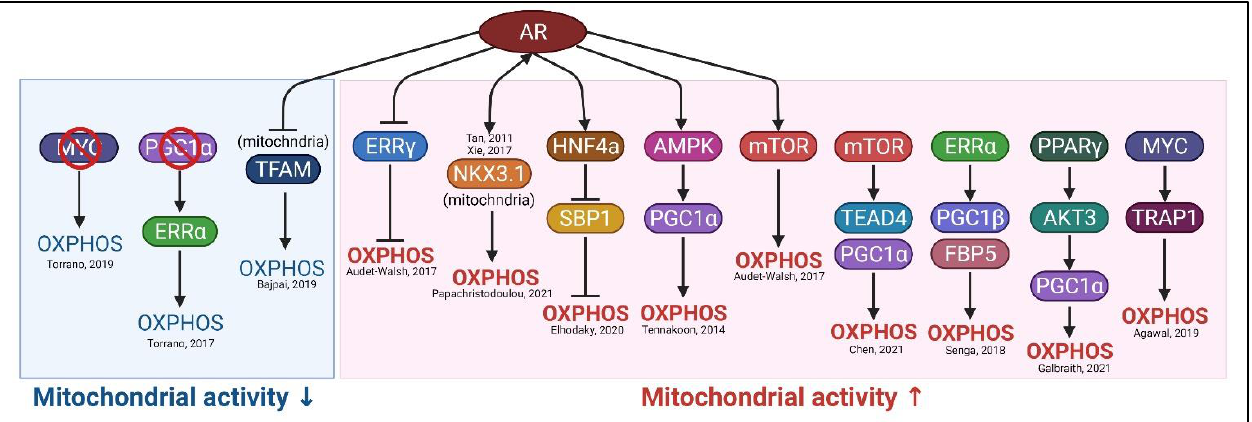
Figure 2. Summary of transcriptional regulations of OXPHOS pathway in PCa. In PCa, the OXPHOS pathway can be regulated by various transcription factors that lead to increased mitochondrial activity (red) or decreased mitochondrial activity (blue).